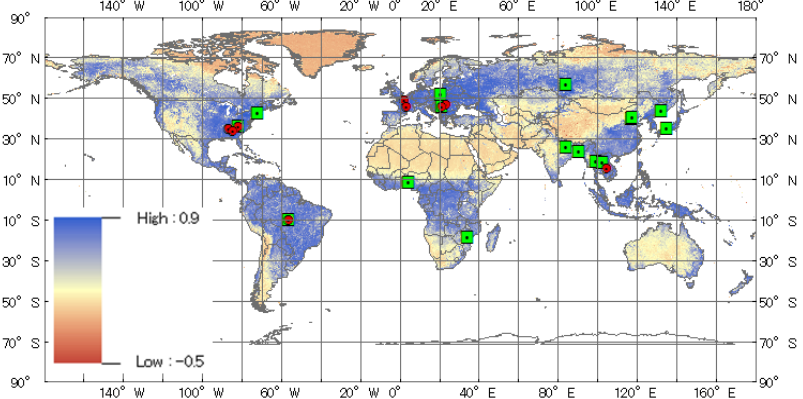
Figure 1. The geographical distribution of AErosol Robotic Network (AERONET) sites (red sites were used for studying reflectance relationships, and green sites were used for validating results) and global Normalized Difference Vegetation Index (NDVI, it ranges from −1 to 1, a 0 or negative value means no vegetation and close to 1 indicates the highest possible density of green leaves) from TANSO-CAI on 29 June 2015.